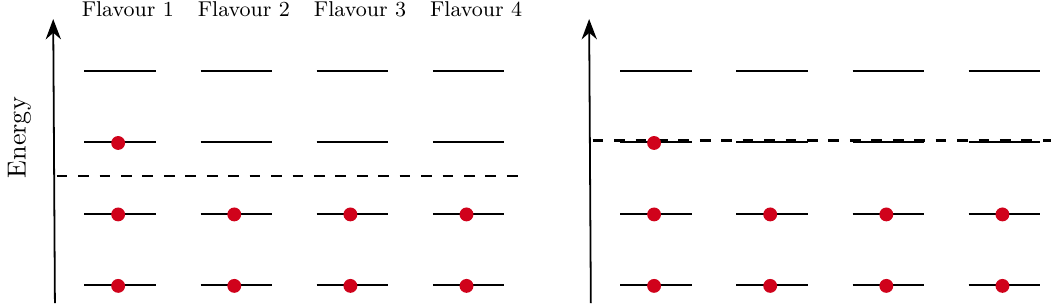
= 1 / 2 , n out = − 1 / 2 , where the 1 2 , 3 , 4